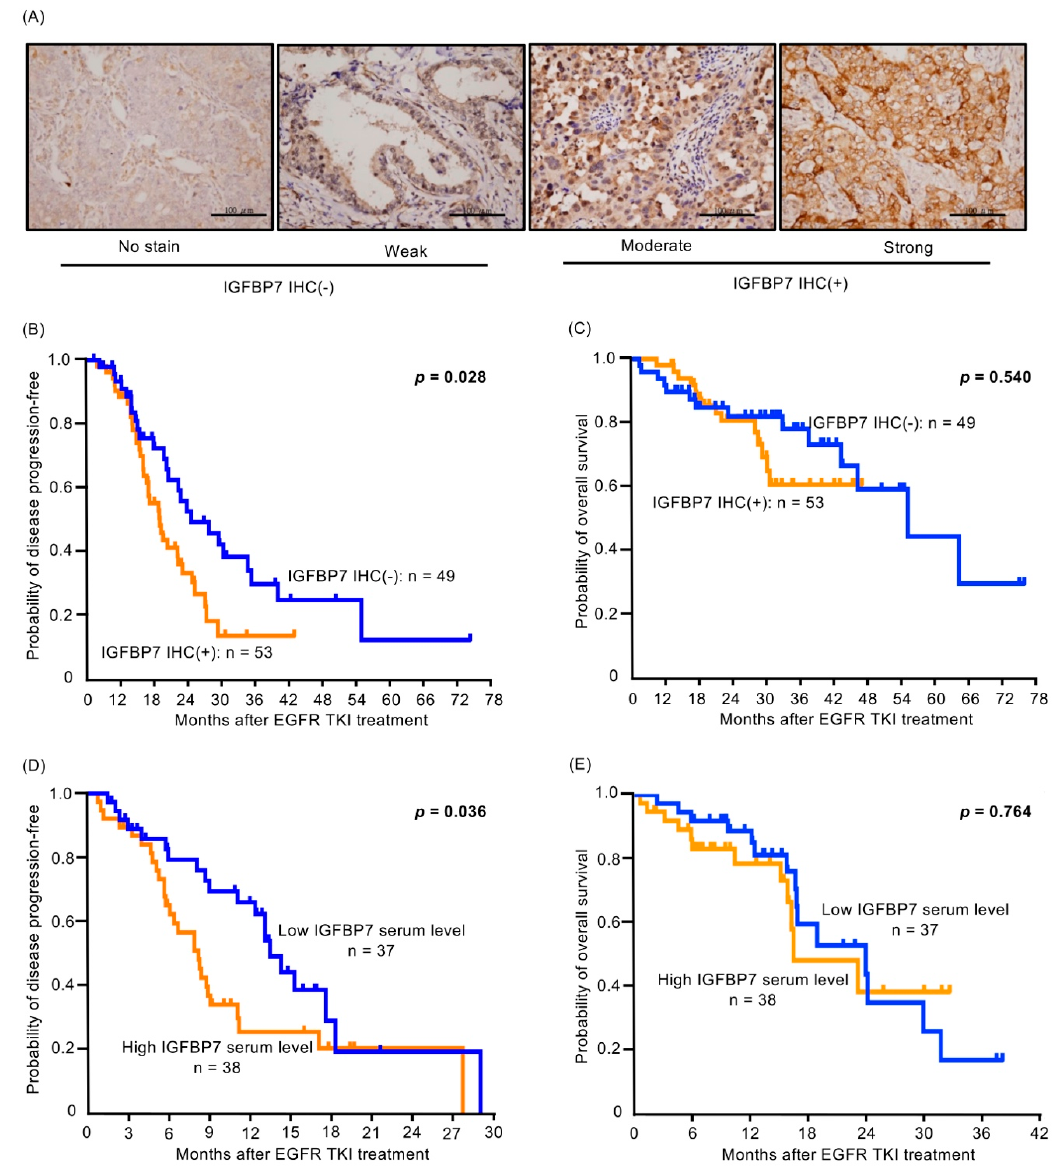
Figure 6. ( A ) Representative immunohistochemical (IHC) staining results for IGFBP7 in samples from patients with lung adenocarcinoma with an EGFR mutation who were administered gefitinib as the first-line treatment. Scale Bar: 100 μ m. ( B ) Patients with IGFBP7 IHC-negative lung adenocarcinoma (blue line) had longer progression-free survival (PFS) with EGFR-TKIs than those with IHC-positive lung adenocarcinoma (yellow line) (median 19.9 months vs. 13.9 months; p = 0.028). ( C ) No significant difference was observed in overall survival (OS) after gefitinib treatment between patients with negative and positive IGFBP-7 IHC (median 52.8 months vs. not reached; p = 0.540) ( D ) Patients with low serum IGFBP7 levels (blue line) had a longer median PFS with EGFR-TKIs than those with high serum IGFBP7 levels (yellow line) (13.4 months vs. 8.1 months; p = 0.036). ( E ) No significant difference was observed in OS after gefitinib treatment between patients with low and high IGFBP-7 serum level (median 23.8 months vs. 26.4 months; p = 0.764).